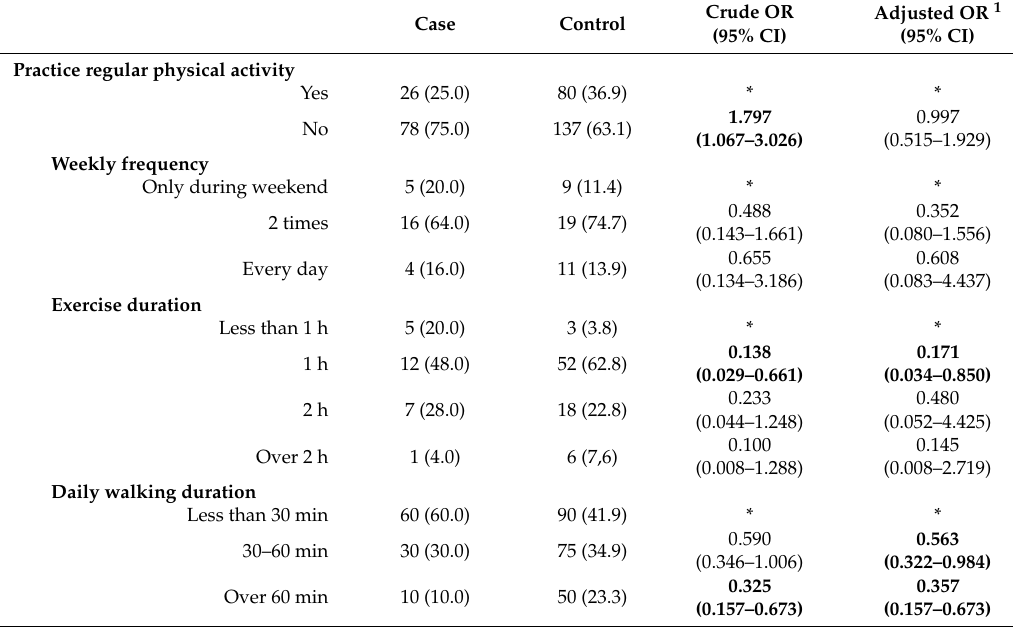
Table 3. OR of thyroid cancer by aspect of physical